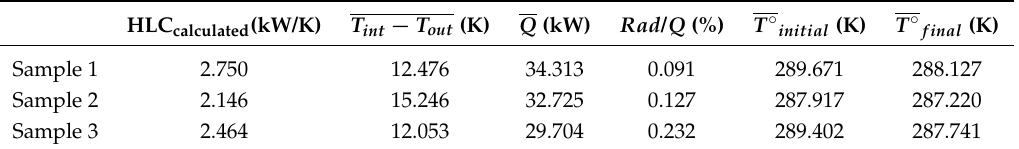
Table 3. Thermal conditions of the three validation samples. These represent the mean difference between indoor and outdoor temperatures, the average heating demand ( Q ), the solar radiation gain (Rad) over the thermal demand and the average temperatures (indoor and outdoor) at the start ( T ◦ initial ) and at the end of the period ( T ◦ final ). HLC, Heat Loss